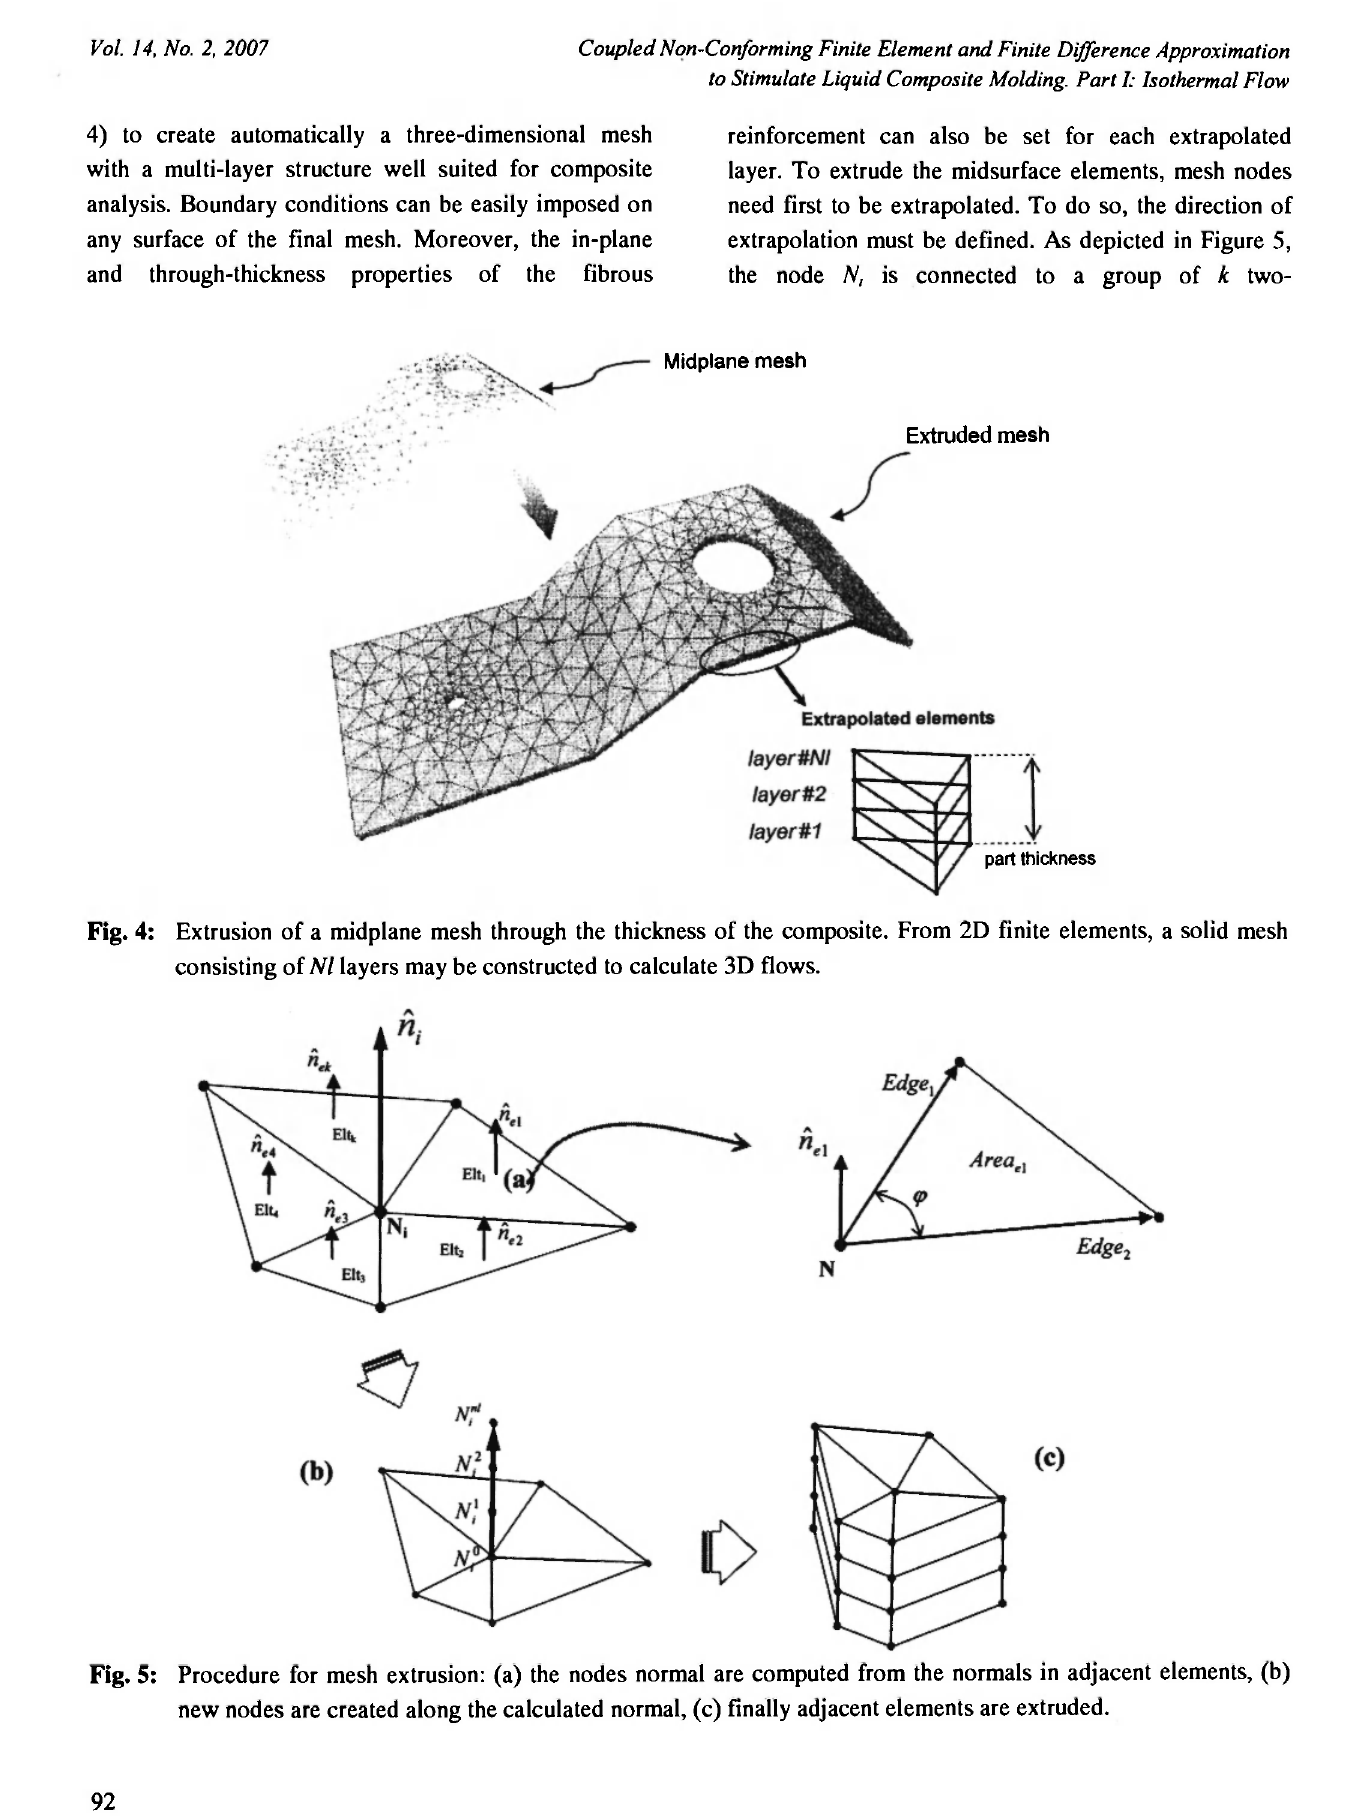
Fig. 5: Procedure for mesh extrusion: (a) the nodes normal are computed from the normals in adjacent elements, (b) new nodes are created along the calculated normal, (c) finally adjacent elements are